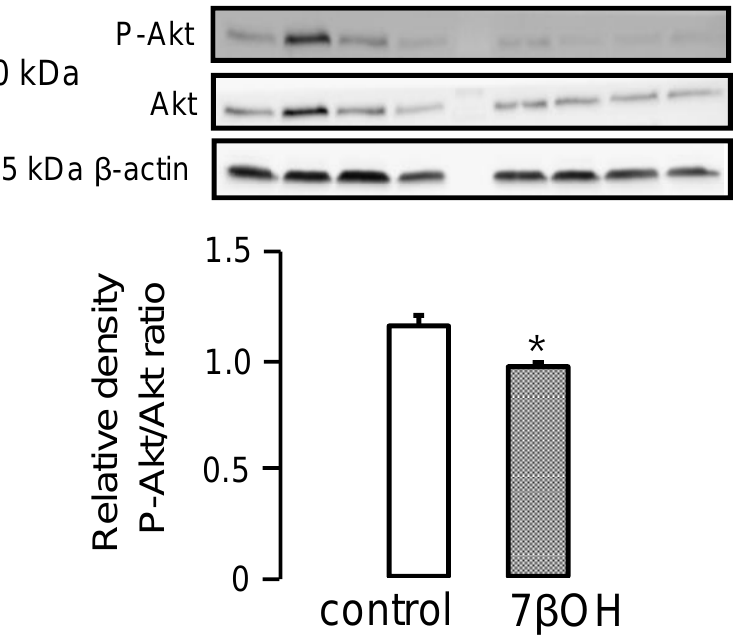
Figure 3. Western blot analysis of Akt and its phosphorylated form in the cytosol of wild-type mice in sedentary conditions ( n = 4) after incubation of cardiomyocytes with 7 β -hydroxycholesterol (7 β OH). Values are expressed as mean ± SEM. * p < 0.05 vs. corresponding group.